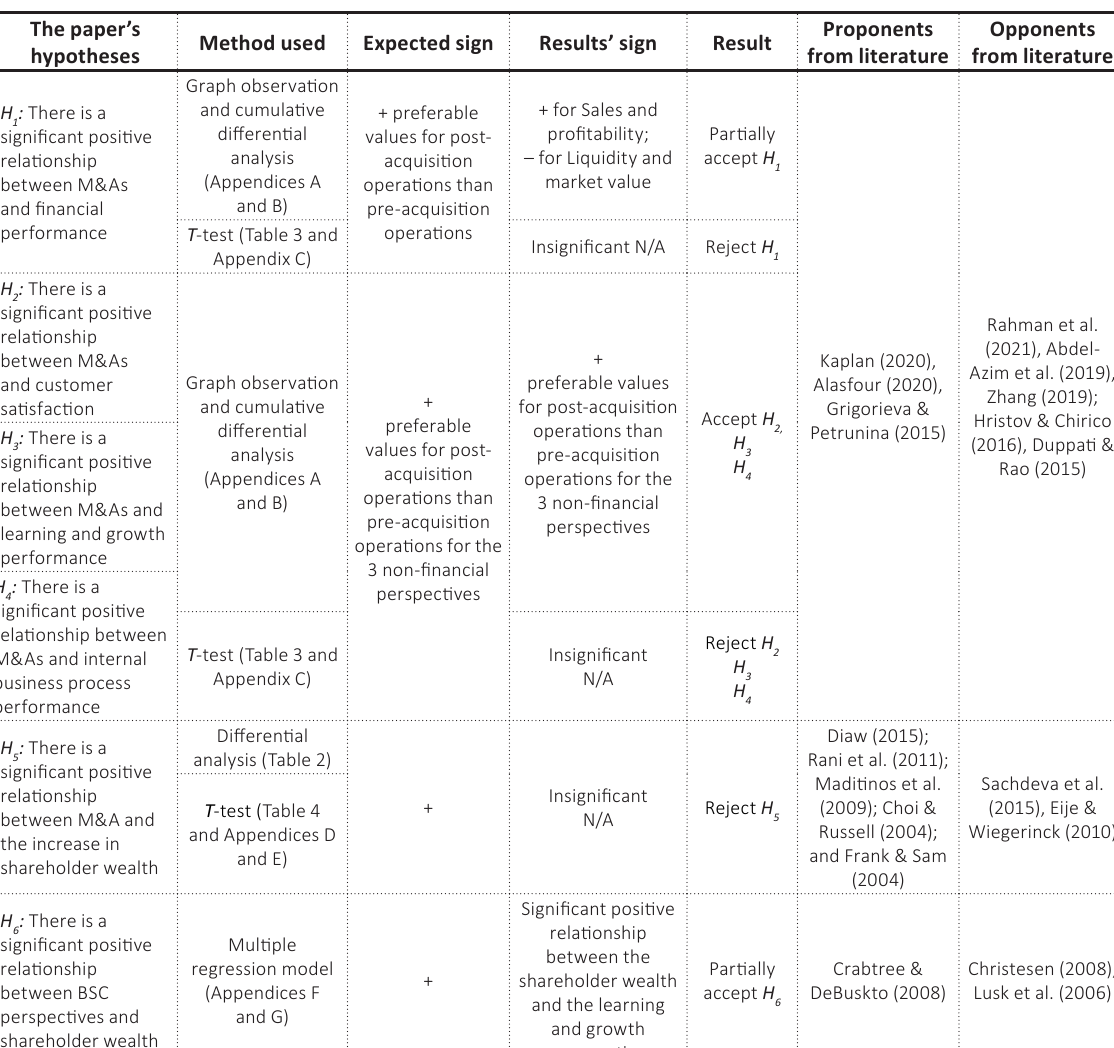
Table 5. Summary for results and their relation to